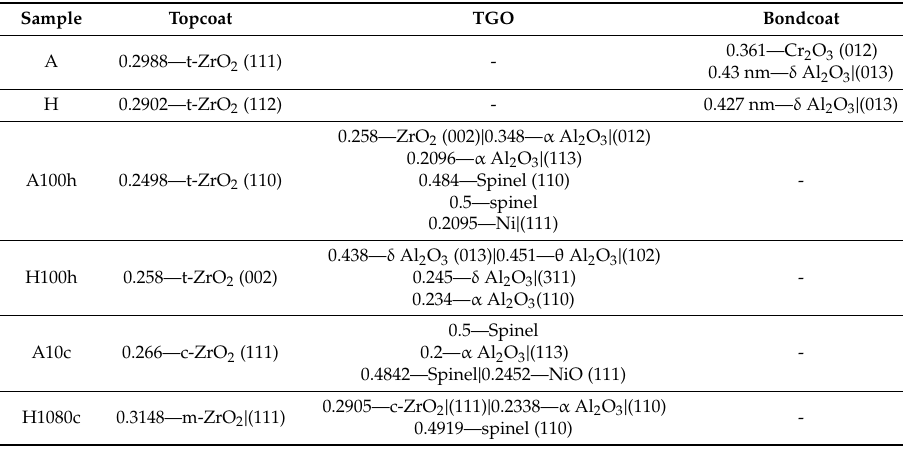
Table 4. Lattice fringes of HRTEM with corresponding